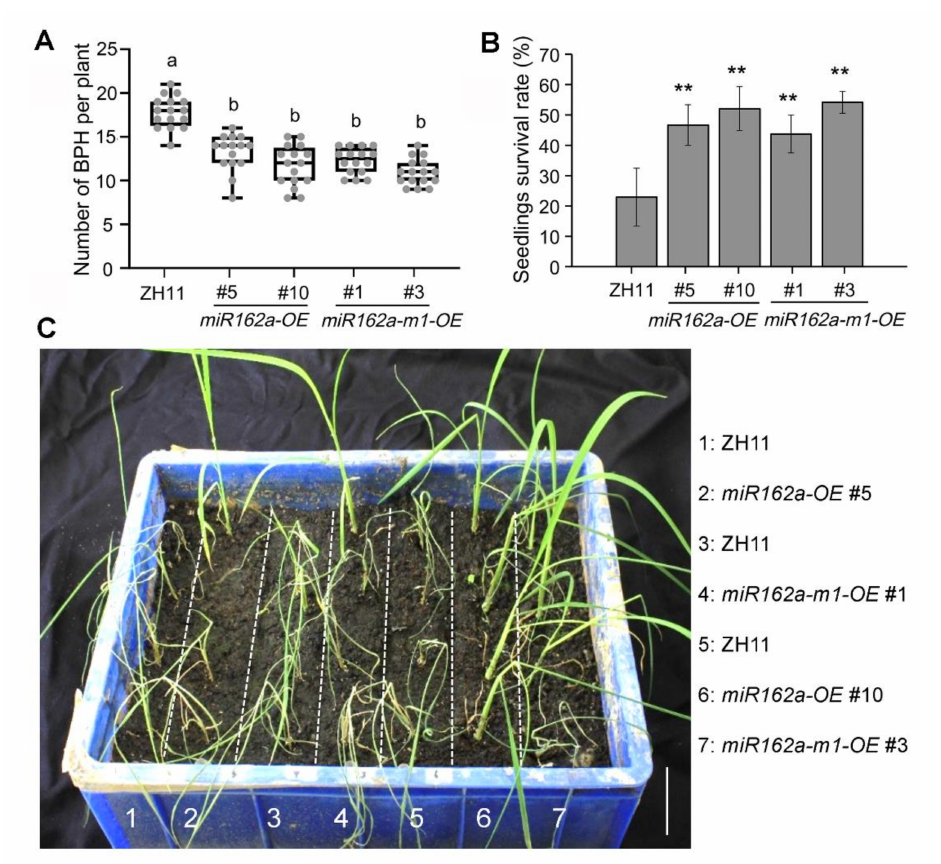
Figure 6. Overexpression of osa-miR162a or osa-miR162a-m1 confers rice resistance to BPH. ( A ) Number of insects settled on indicated genotypes at 48 h after infestation in a host choice test. Fifteen four-leaf-stage young seedlings were infested with 15 nymphs of the third instar per plant. Measurements are plotted as boxes and whiskers displaying mean ± SD. Individual data points are shown as dots. Significant differences were determined using one-way ANOVA followed by Tukey post hoc test. Letters indicate significantly different groups. ( B ) Plant survival rates of indicated genotypes at 10 days after infestation. The data are presented as mean ± SD of three biological replicates ( n = 3). ** p < 0.01 (Student’s t -test). ( C ) Representative image of one replicate for ( B ). Scale bar = 4